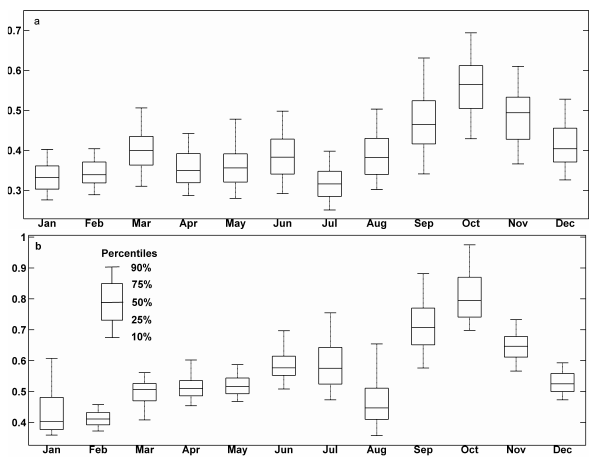
Fig. 3. Box plots of relative root mean square error for 251 1/8 ◦ grid cells due to: (a) temporal disaggregation of monthly observed precipitation to daily scale, and (b) spatial downscaling of 1-month lead ECHAM4.5 monthly precipitation